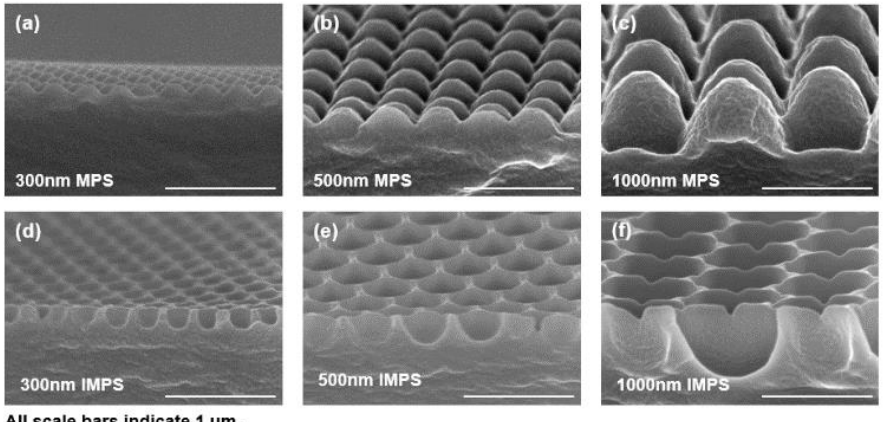
Figure 2. ( a – c ) SEM images of MPS arrays with three di ff erent sizes (300, 500 and 1000 nm) composed of PUA after the use of the double replication method; ( d – f ) SEM images of IMPS arrays in the same order as that depicted in ( a – c ).